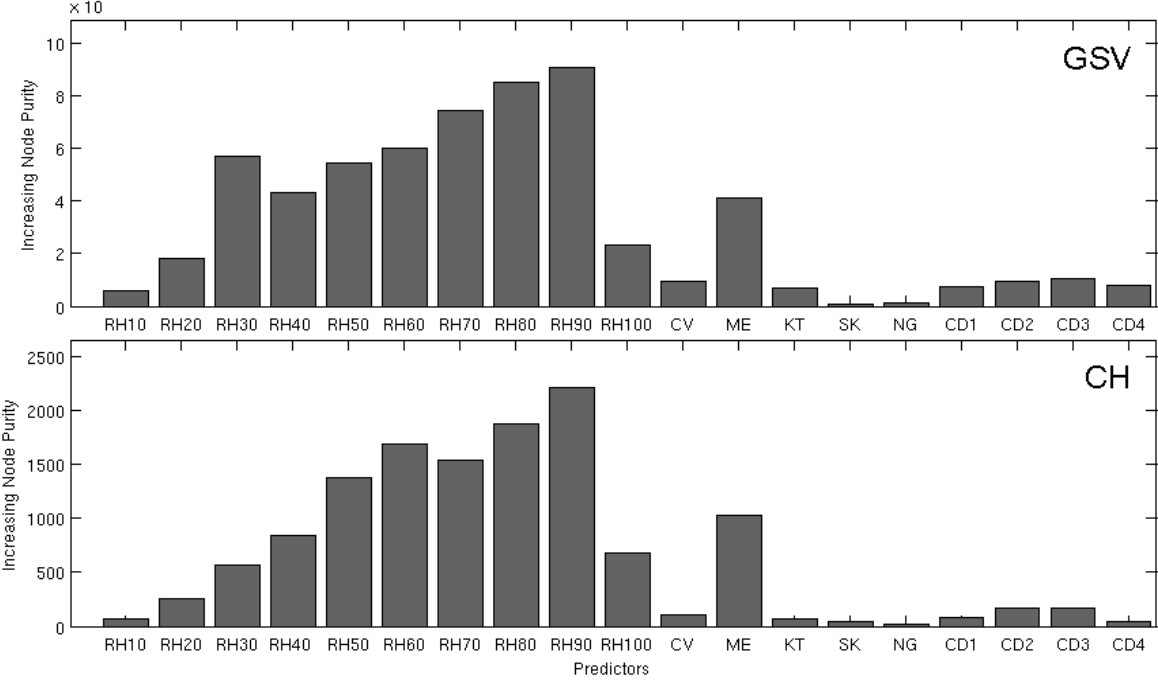
Figure 4. randomForest predictor importance ranking for the ALS-based retrieval of GSV and CH.